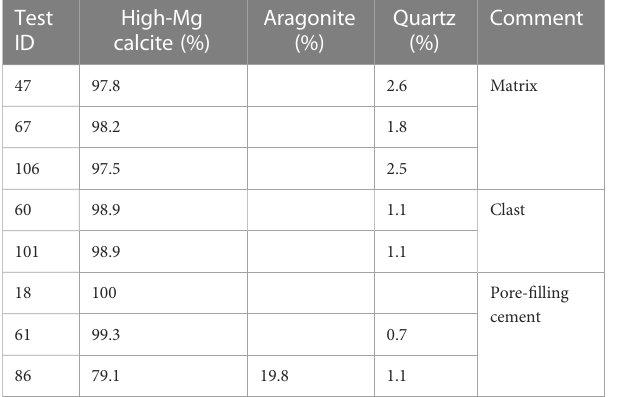
Sample locations are indicated in Figure